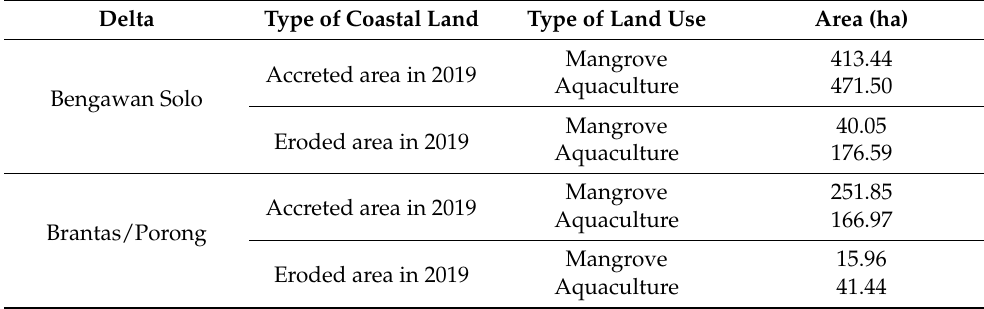
Table 3. Summary of major land use in 2000 and 2019 in the coastal accreted and eroded